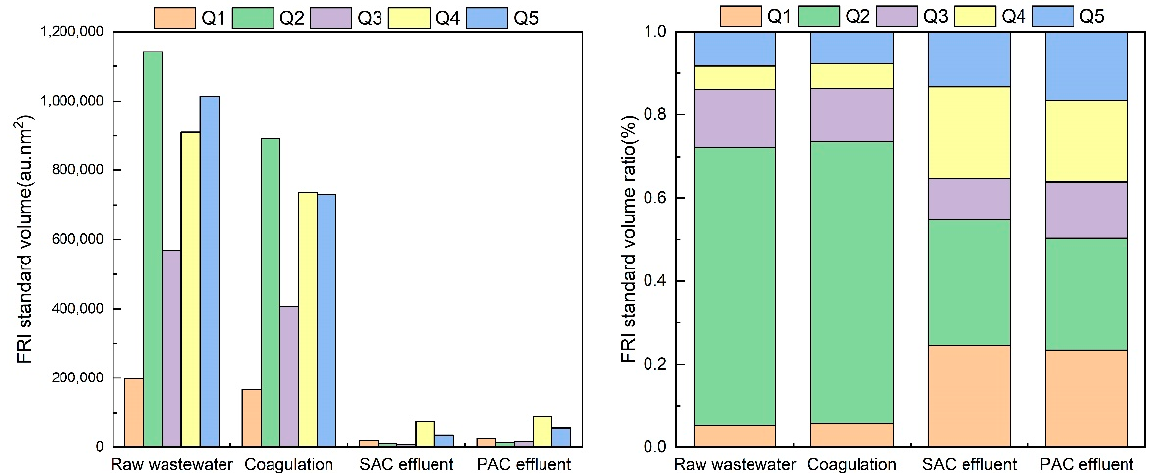
Figure 6. Integral standard volume and proportion of each fluorescence area of 3D-EEM. Q1 corre- sponds to tyrosine-like organic compounds; Q2 corresponds to tryptophan-like organic com- pounds; Q3 corresponds to fulvic acid-like organic compounds; and Q4 and Q5 corresponded to soluble microbial by-products and humic acid-like organic compounds, respectively.